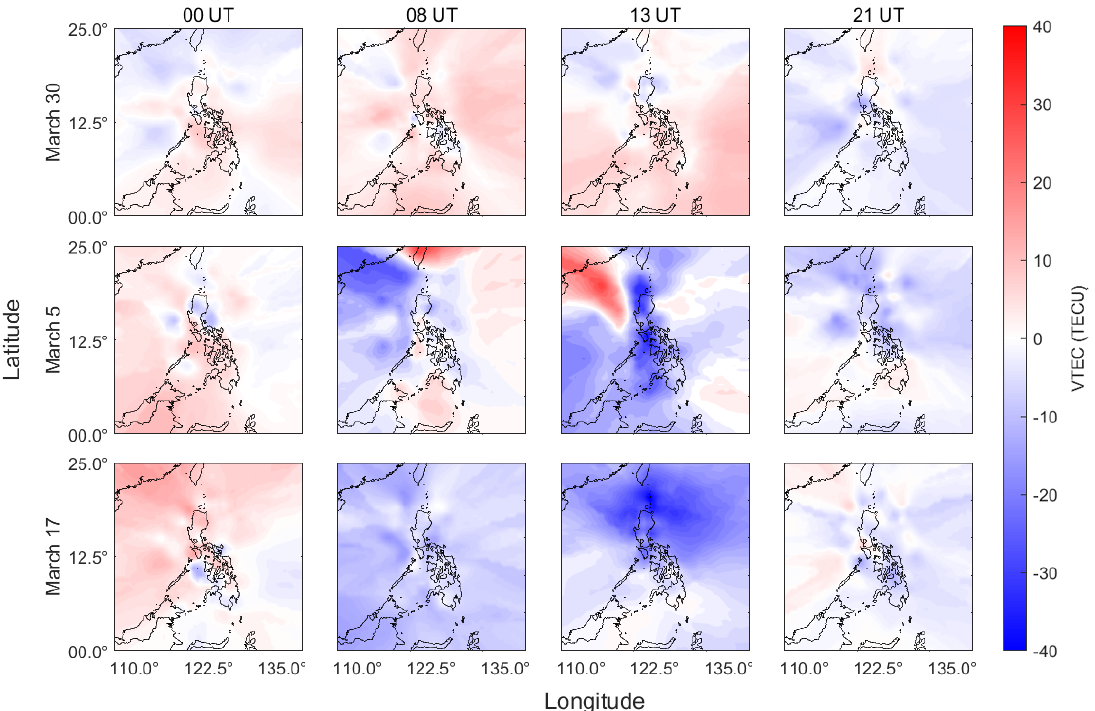
Figure 10. 2-dimensional map of VTEC on 30 March (quiet), 5 March (scintillated), 17 March (active) 2015 at 0 UT, 8 UT, 13 UT and 21 UT.